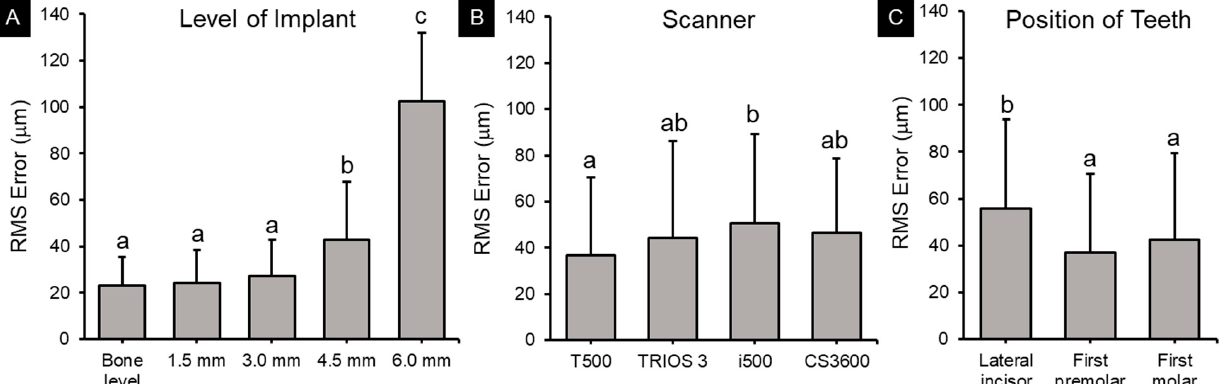
Figure 6. Trueness according to implant placement depth ( A ), scanner ( B ), and tooth position ( C ). Different lowercase letters indicate significant differences within each group. Data are mean and standard deviation values.